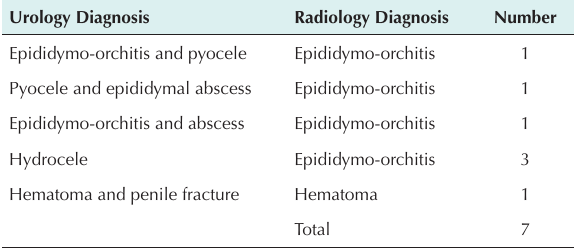
Table 2. Cases With the Lack of Contingency Between the Diagnosis of Emergency Medicine Assistants and Urologists Urology Diagnosis